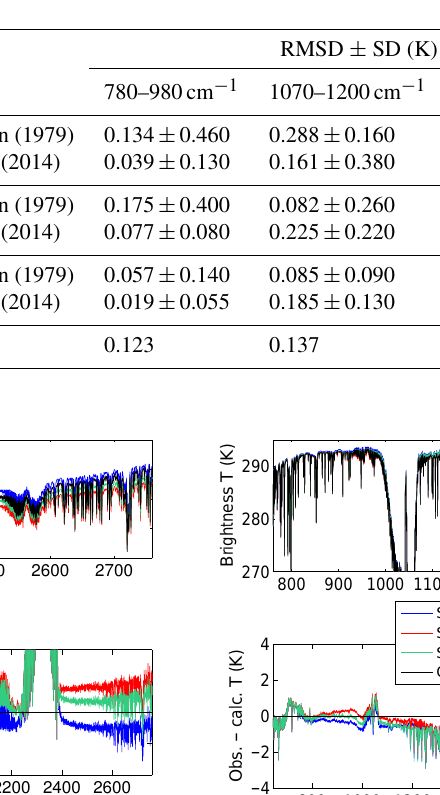
Table 3. Summary of root mean square differences and related standard deviations computed using the two sets of refractive indices in the three selected scenarios. Data are computed averaging the residuals on a spectral grid with a sampling of 15cm − 1 , the same used by σ -IASI-as to compute aerosol extinction, in order to suppress most of the variability due to gas spectral lines, retaining only the variability due to aerosol extinction.